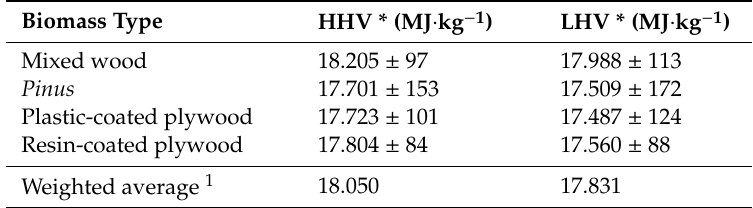
Table 5. Biomass higher heating value (HHV) and lower heating value (LHV).